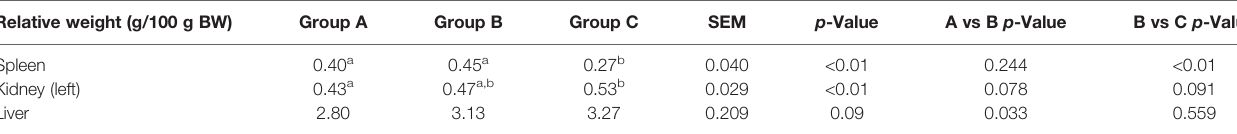
TABLE 2 | The effects of combined OTA and AFB1 on the relative weight of organs in pullets (n = 6, mean ± SEM). Relative weight (g/100 g BW) Group A Group B Group C SEM p -Value A vs B p -Value B vs C p